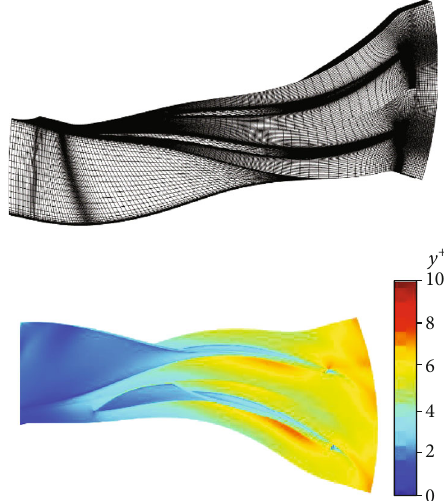
Figure 3: The sketch and y + of the 1.52 million